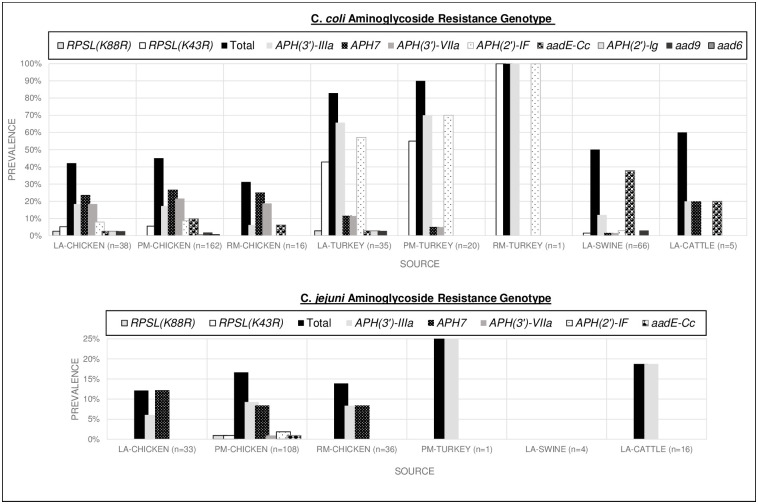
C. coli and C. jejuni AMR gene prevalence by source conferring aminoglycoside resistance.AMR genes inferring resistance to the following antimicrobials: aad6: streptomycin; aad9: aminoglycosides (specific antibiotics are not listed in the database for this gene); aadE-Cc: streptomycin; aph(2’)-If: amikacin, gentamicin, kanamycin, tobramycin; aph(2’)-lg: amikacin, gentamicin, kanamycin, tobramycin; aph(3’)-IIIa: amikacin, kanamycin; aph(3’)-VIIa: amikacin, kanamycin; aph7: hygromycin. Chart coding: Live Animal (LA), Processed Meat (PM), Retail Meat (RM).